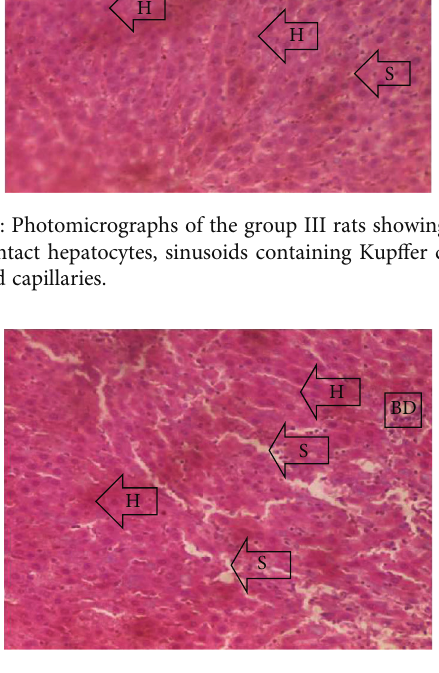
Figure 4: Photomicrographs of the group IV rats showing mildly distorted liver of sinusoids with capillaries and increased in fl ammatory cells, intact hepatocytes, patent bile duct (BD), and congested hepatic artery (HA).